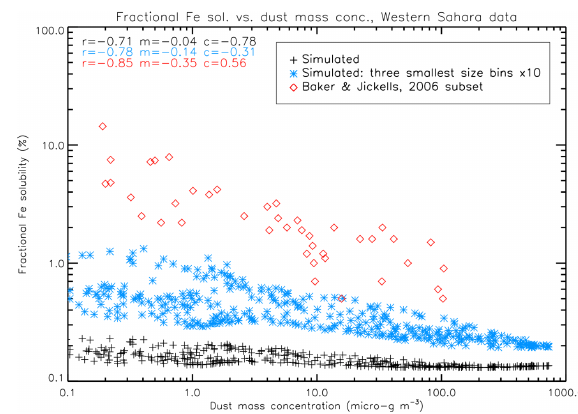
Fig. 5 Modelled dust mass size distributions (left-hand y-axis) from the two gridboxes over the ocean, one proximal to the dust source (burgundy line), and one distal location (dark blue line). The location of these two gridboxes is indicated by white stars in Fig. 4. The black and light blue dotted lines (right-hand y-axis) show the measured size-resolved Fe solubility from the Western Sahara soil sample as compared to the hypothetical curve when the measured FS-Fe from three smallest size bins (<0.18-0.32 µm; 0.32-0.56 µm; and 0.56-1.0 µm ) were increased by a factor of ten.